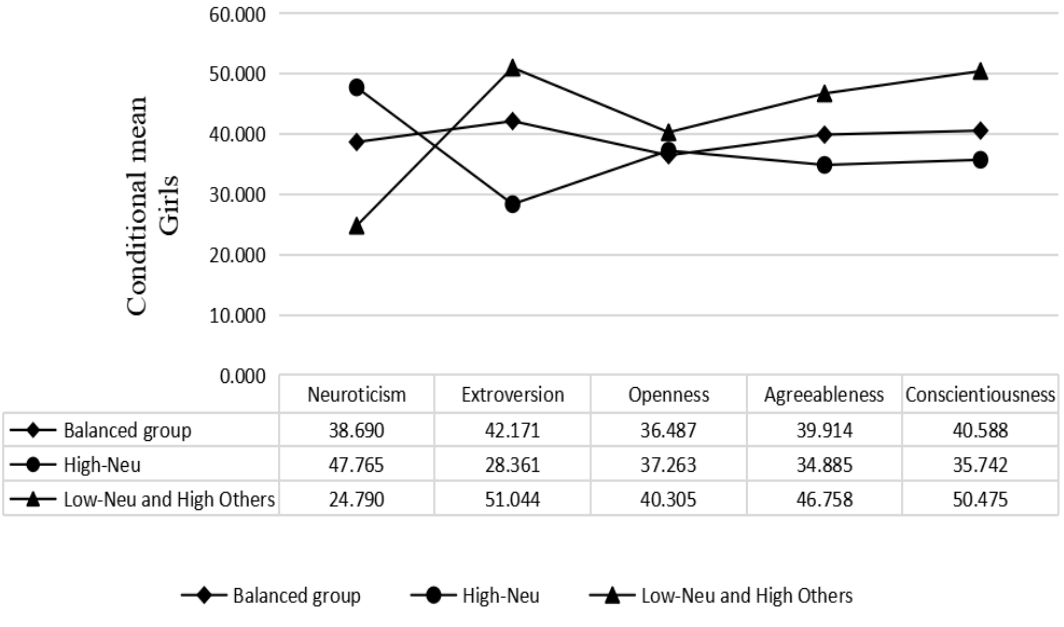
Figure 3. Plot of the conditional mean distribution for the latent categories (girls).